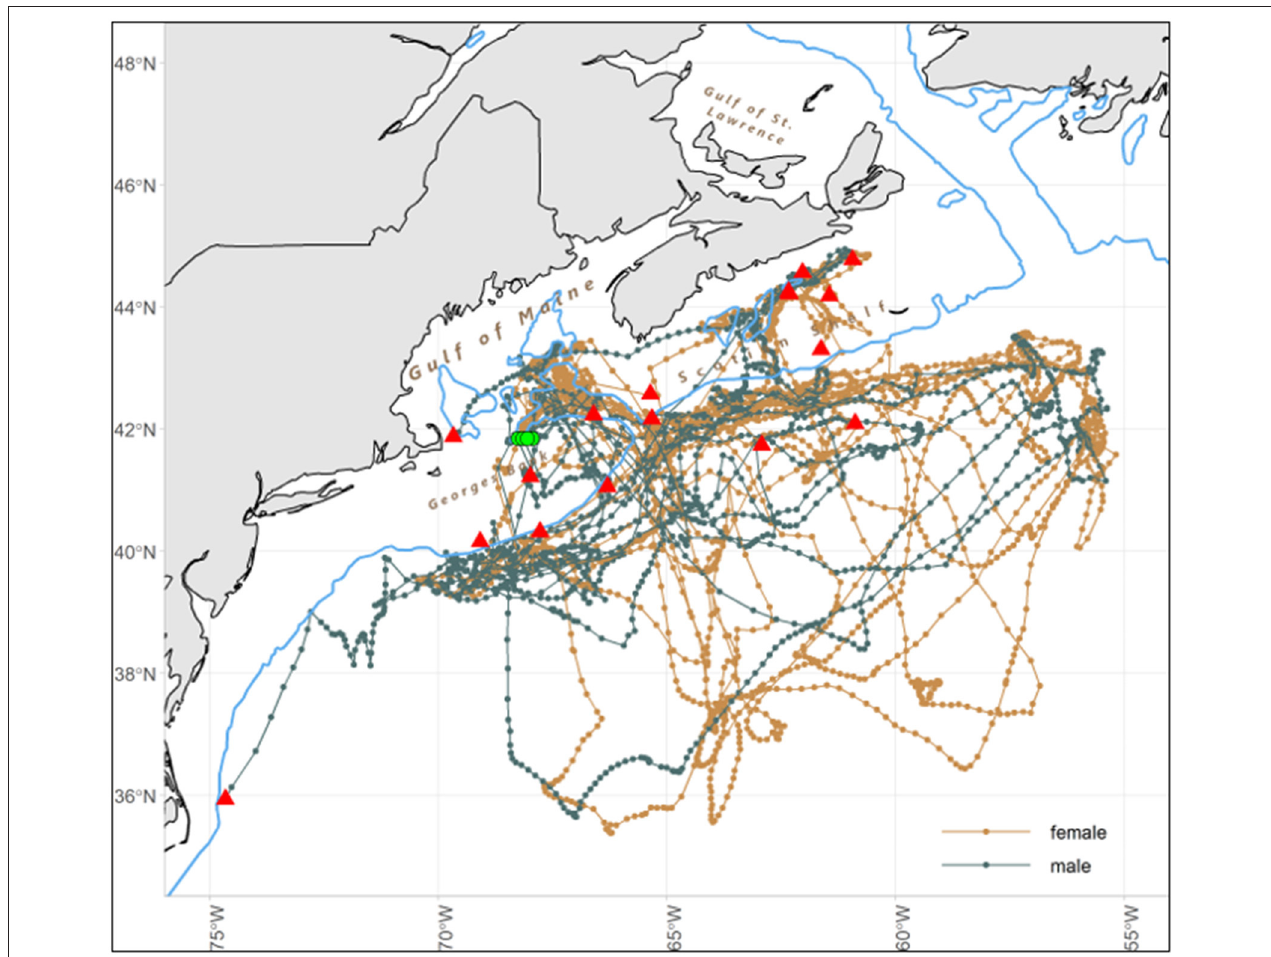
FIGURE 1 | Most probable tracks for 17 juvenile porbeagle sharks, stratified by sex, tagged in the western North Atlantic with tagging (green points) and pop-up (red triangle) locations, and shelf edge (200m isobath, blue